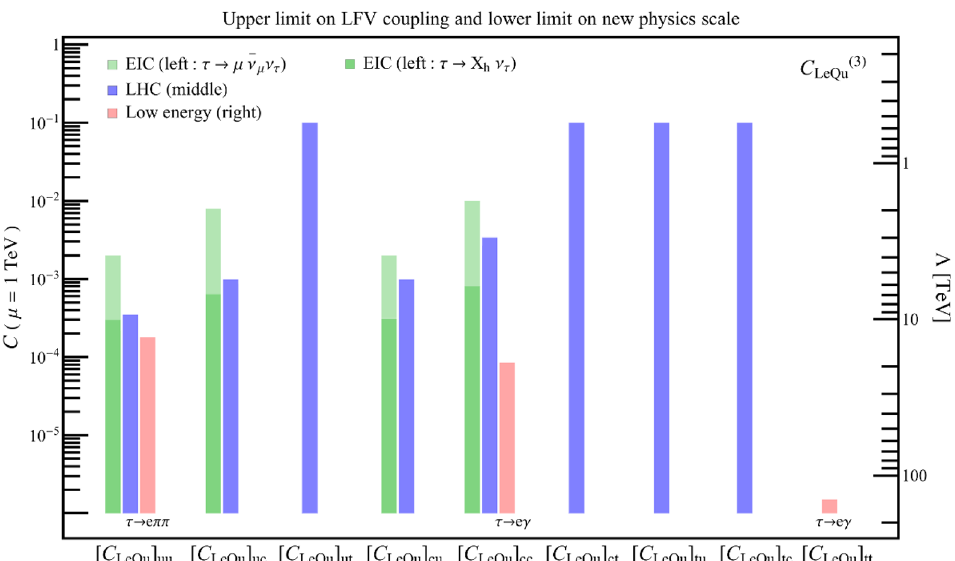
(leftmost axis) and lower limit on new physics scale Λ (rightmost Figure 22 . Upper limit on C (3) LeQu axis). For the EIC expected sensitivity, the light green bar corresponds to the result in table 7, while the dark green one represents the case in hadronic tau decay mode assuming (cid:15) n b = 0 in tables